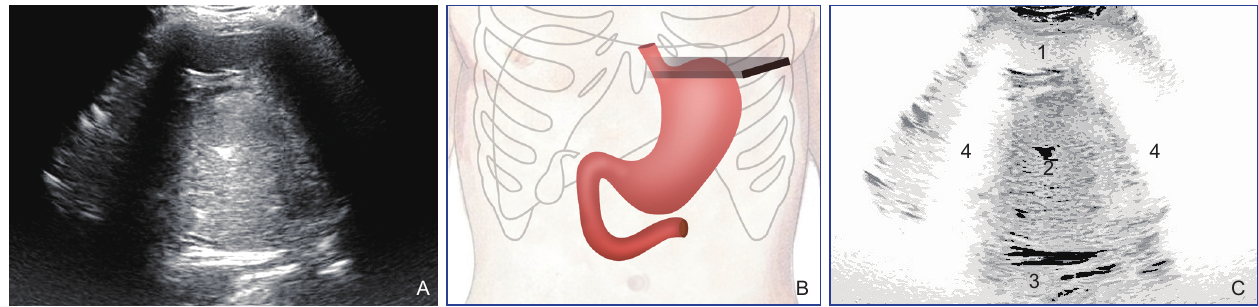
Figure 5 Short-axis section of the gastric fundus ultrasonic image and schematic diagram of the canning (scanning through the left intercostal section). A, Ultrasound image; B, Schematic scanning diagram; C, Ultrasound schematic diagram (1, Spleen; 2, Gastric fundus; 3, Aorta; 4, Acoustic shadow of ribs)